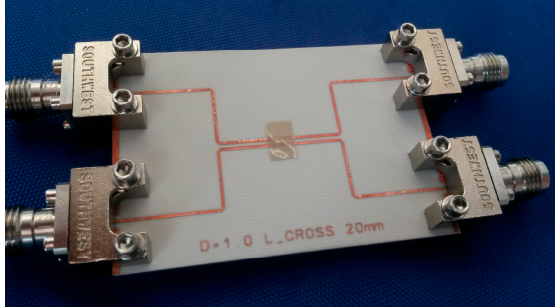
Figure 17. Coupled microstrip line assembly with an ACP specimen on top.